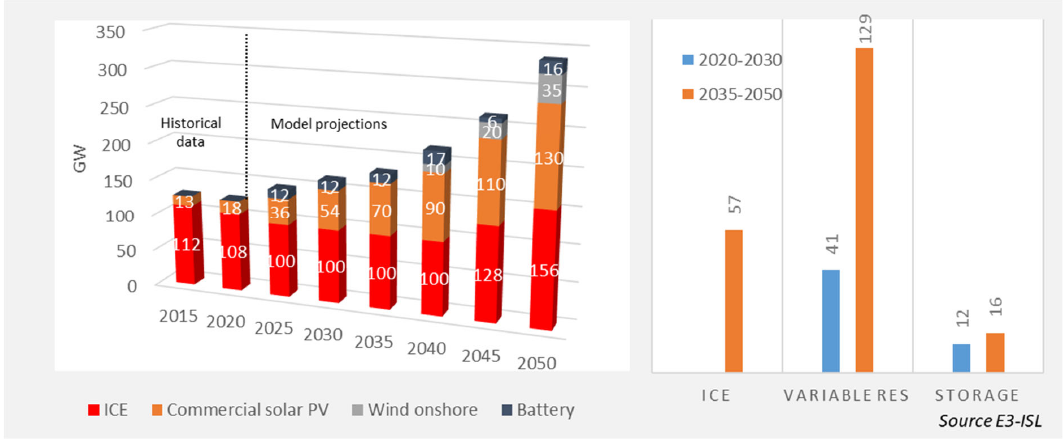
Figure 10 . Baseline—operating power capacities and investment in new capacities by plant type . Figure 10. Baseline—operating power capacities and investment in new capacities by plant